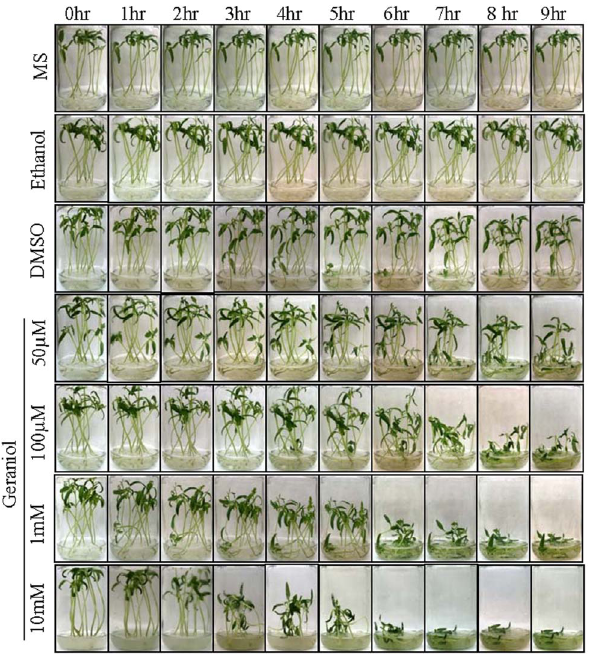
Figure 3. Phytotoxic effect of geraniol on tomato seedlings. Seedlings were fed with MS medium containing 50 m M to 10 mM geraniol, 20% DMSO and 100 mM ethanol. Seedlings treated with geraniol showed rapid loss of vigor and